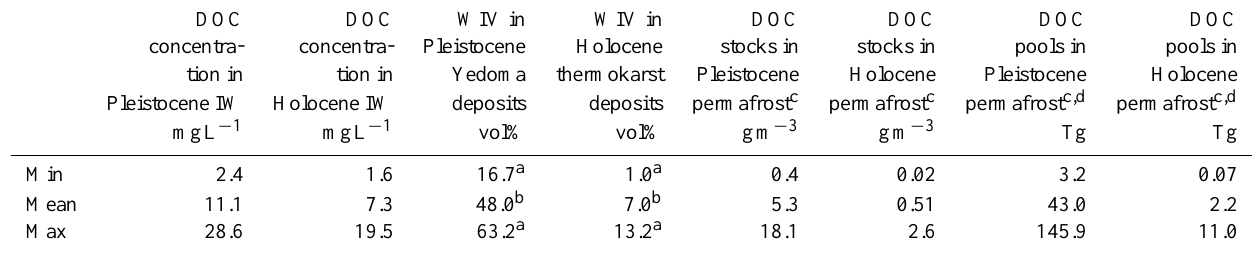
a WIV data by Ulrich et al. (2014). b Mean WIV data by Strauss et al. (2013). c This includes ice wedges only. d According to Strauss et al. (2013) undisturbed Pleistocene Yedoma covers 416000 km 2 with a mean thickness of 19.4 m , whereas Holocene thermokarst deposits cover 775000 km 2 with a mean thickness of 5.5 m .